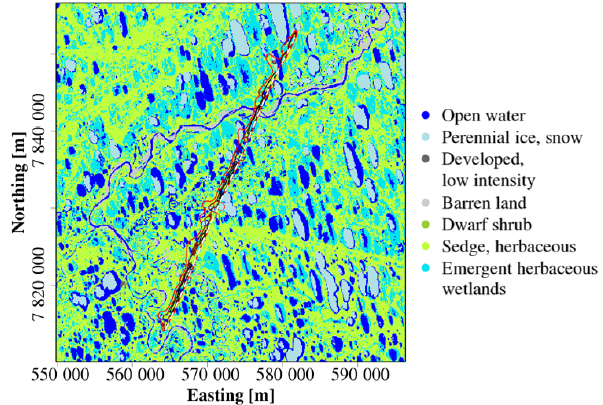
Figure 11. The composite flux footprint along the flight line (30, 60, and 90% contour lines) superimposed over the National Land Cover Database. The white dashed line represents the aircraft flight